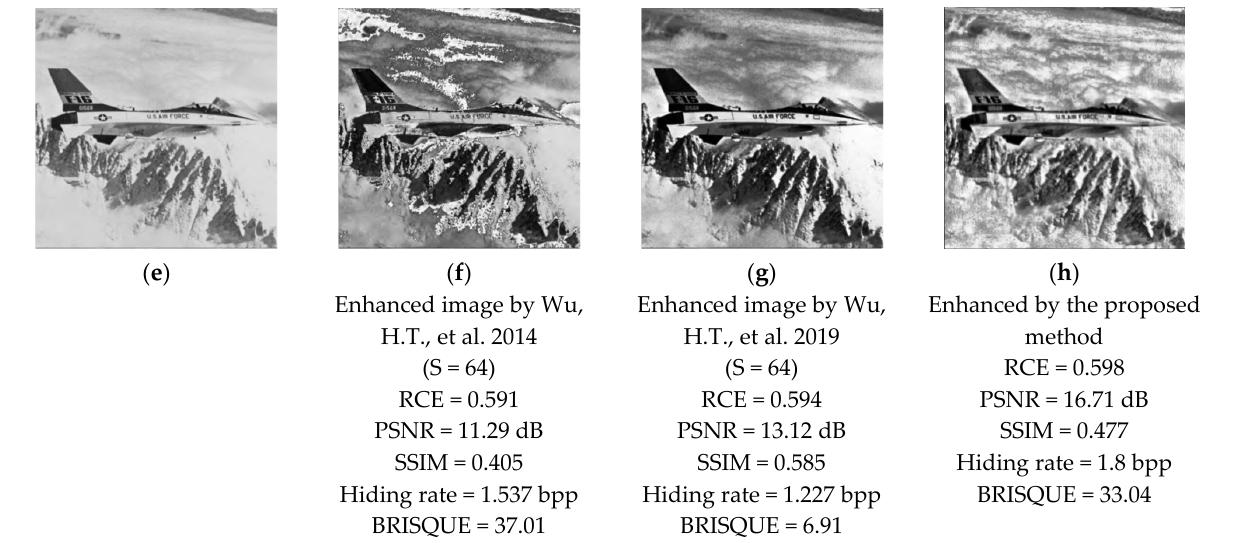
Figure 16. Two original images of USC-SIP dataset ( a ) Baboon and ( e ) F-16. Enhanced images obtained by algorithms in ( b , f ) [21], ( c , g ) [31], and ( d , h ) the present proposal.